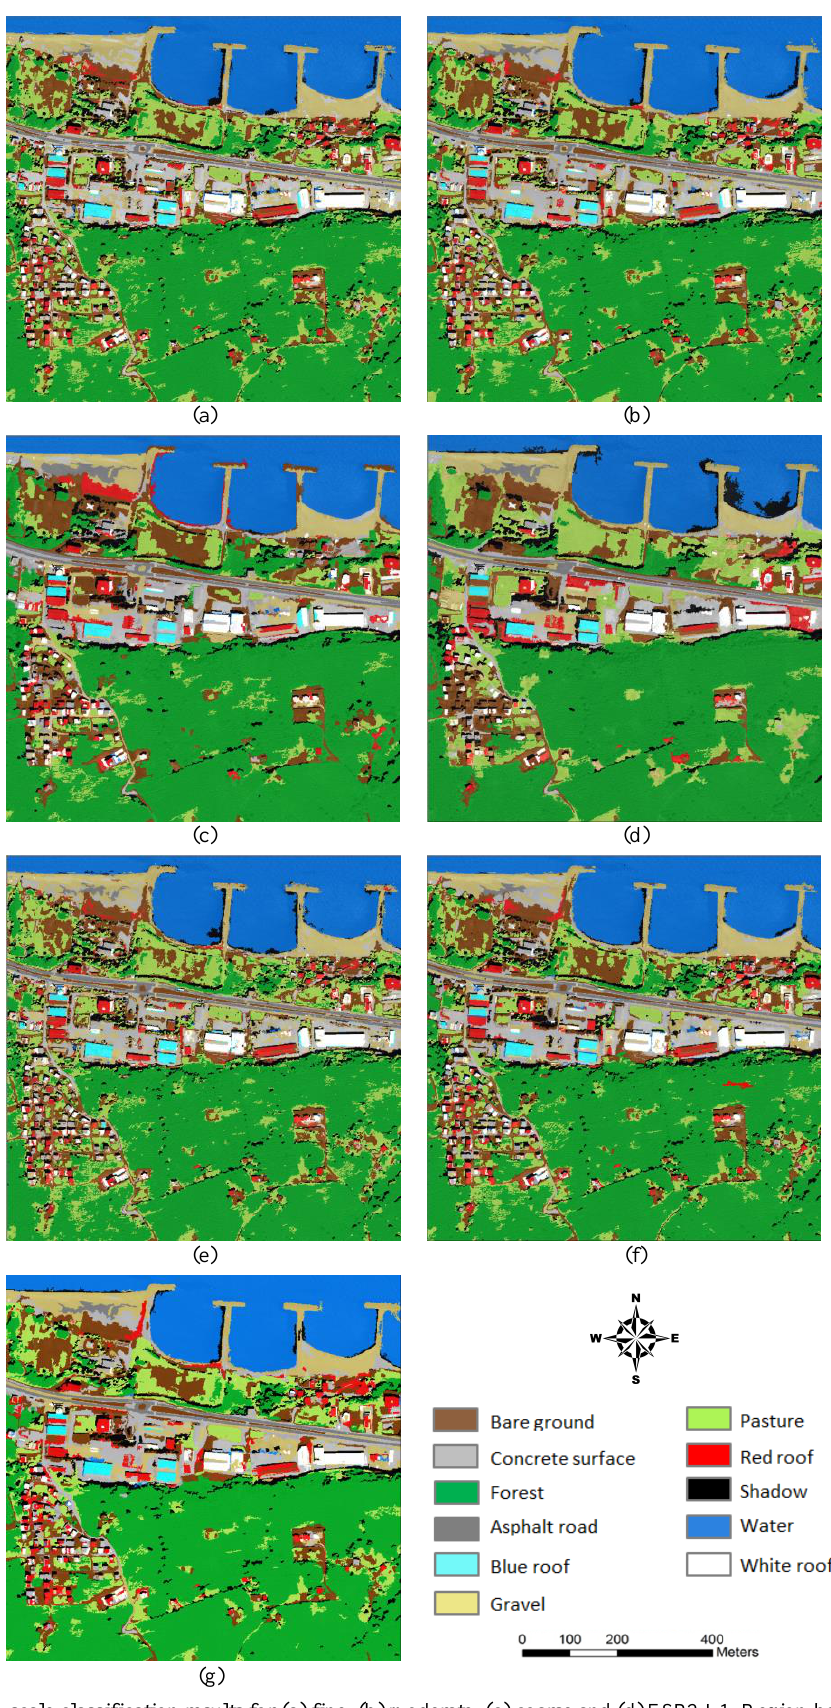
Figure 5. Single-scale classification results for (a) fine, (b) moderate, (c) coarse and (d) ESP2-L1. Region-based (multi-scale) classification results for (e) fine, (f) moderate and (g)